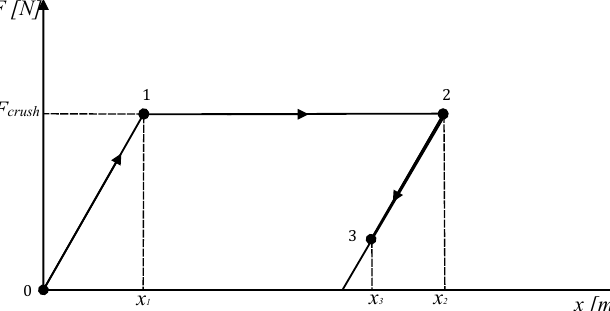
Figure 5. Honeycomb crash absorber load-deformation